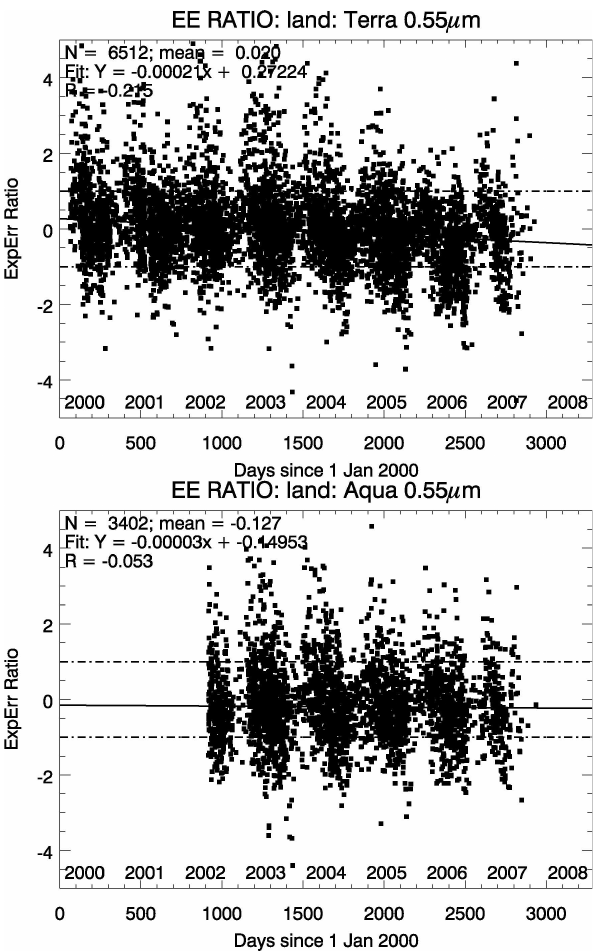
Fig. 15. Time series of Error Ratio (ER; Eq. 3) of MODIS C005 0.55µm AOD compared to seven long-term AERONET sites, for Terra (top) and Aqua (bottom). Points between the dashed lines ( ± 1) are cases where MODIS matches AERONET within EE over land ( ± 0 . 05 ± 0 . 15 τ ). The solid line is the linear regression. At the top of the plot is text that describes: the number of collocations (N) , the regression equation and correlation (R)